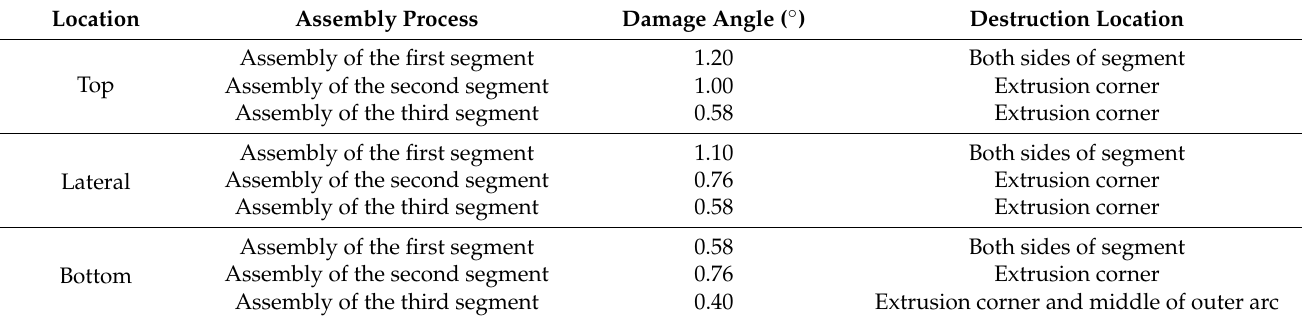
Table 5. Damage to the